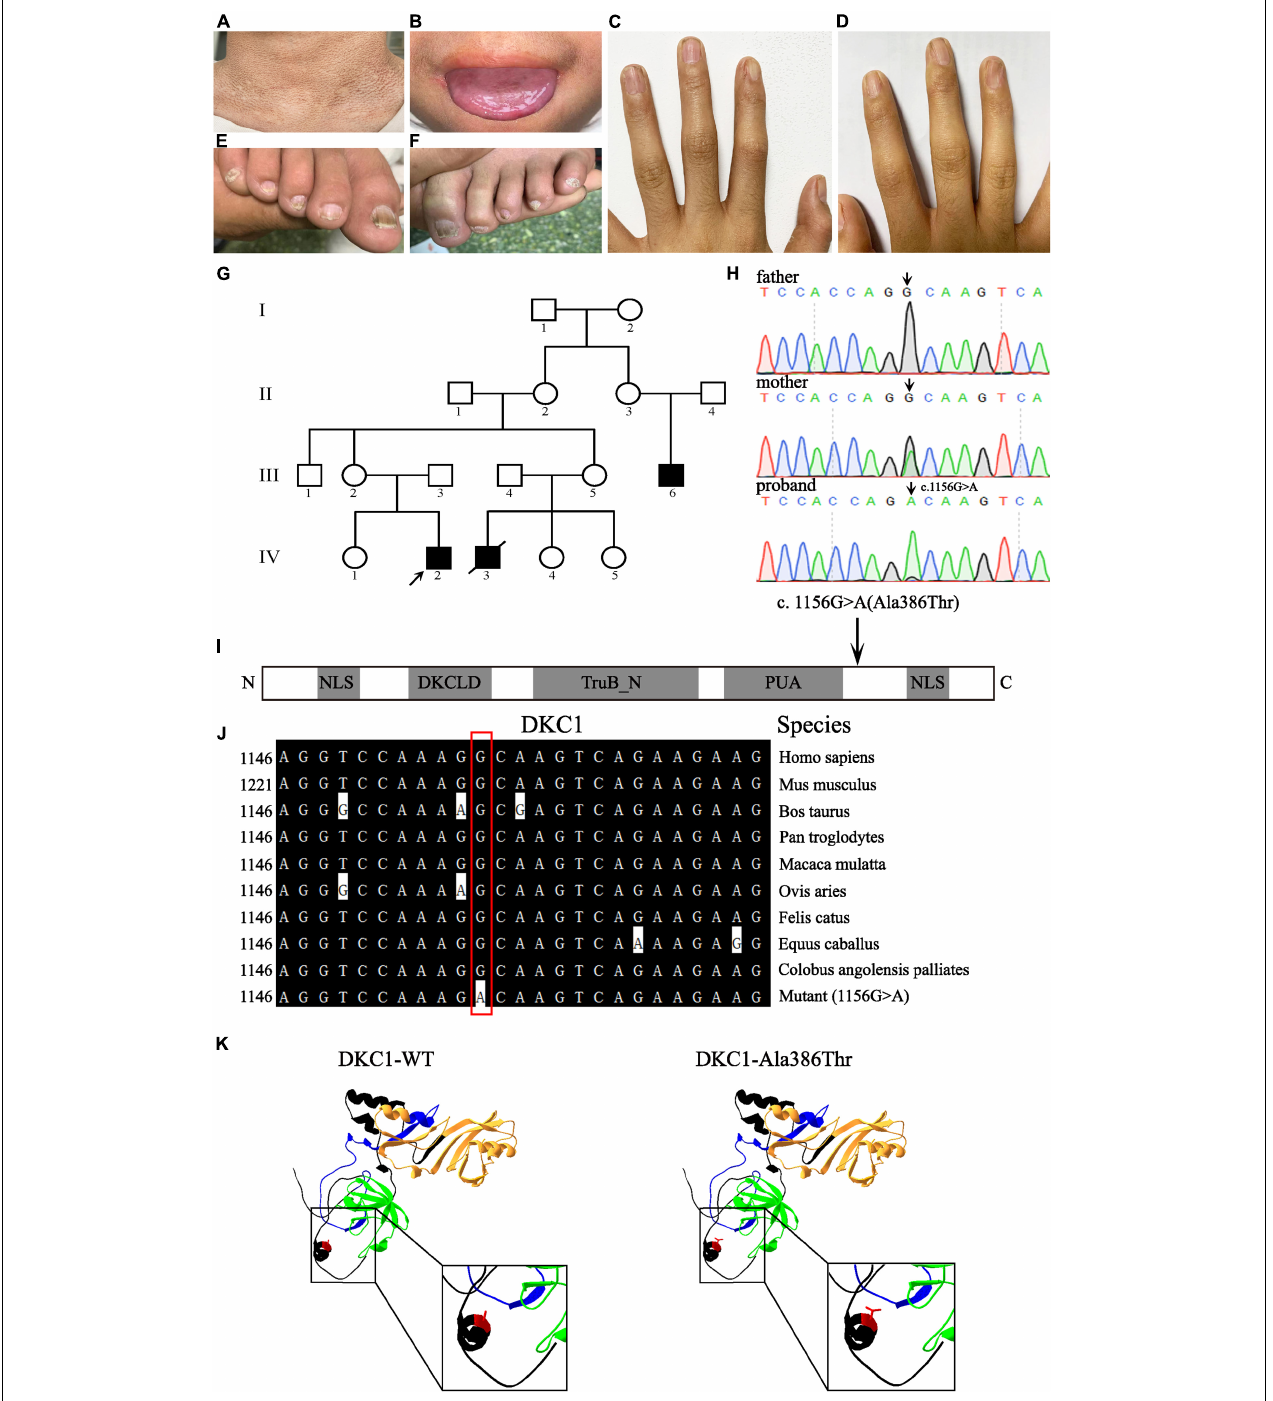
FIGURE 1 | Clinical features of the proband and pedigree, sequencing analysis, and DKC1 mutation investigations. Pigmentation on the neck (A) , mucosal leukoplakia on the tongue (B) , finger nail ridging, toenail ridging, and longitudinal splitting (C–F) in the proband. (G) The pedigree of the family. The arrow indicates the proband. (H) Sequencing chromatograms show the proband with a hemizygous mutation DKC1 c.1156G > A, the proband’s mother with the same heterozygous mutation; the black arrow indicates the position of the nucleotide mutation. (I) A linear representation of the DKC1 protein shows the location of the N-terminal nuclear localization signals (NLS), DKCLD, TruB_N, and PUA domains. The black arrow shows the positions of the amino acid substitutions. (J) The mutant site (c.1156G > A) of DKC1 is highly conserved phylogenetically among the indicated species. (K) The mutant proteins were structured by the Swiss-Model online software and compared with the wild type. Ribbon representation of the human DKC1 and map of the studied variant localization obtained by homology modeling analysis. The wild-type and mutant monomers are shown in black; DKCLD, TruB_N, and PUA domains are shown in blue, orange, and green, respectively. Amino acid Ala386 is shown as